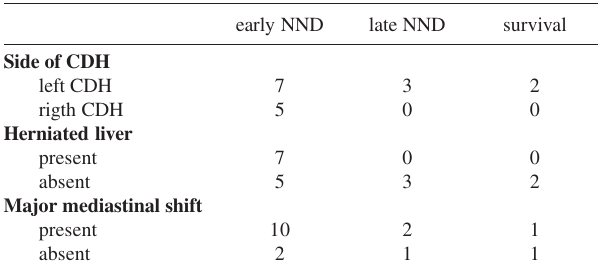
Table 3 - Outcome for neonates with isolated CDH, by prenatal ultrasonographic